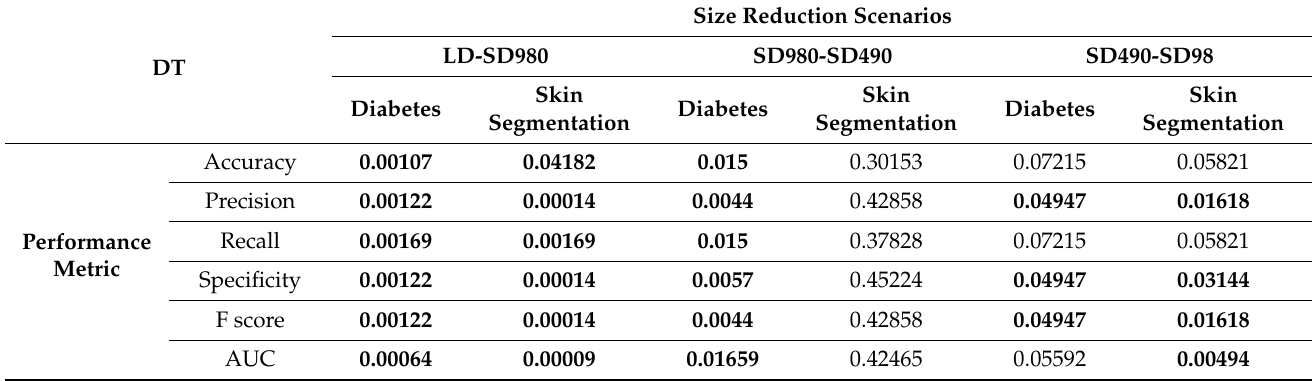
Table A8. p -values for different size reduction scenarios using the DT model; bold values are significant.